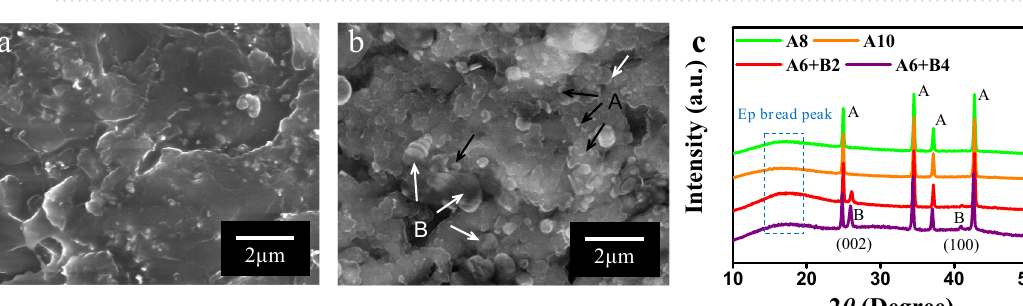
Figure 1. ( a ) FTIR spectrum of, and ( b ) TGA curves of the alumina spheres and the BNNs powder.